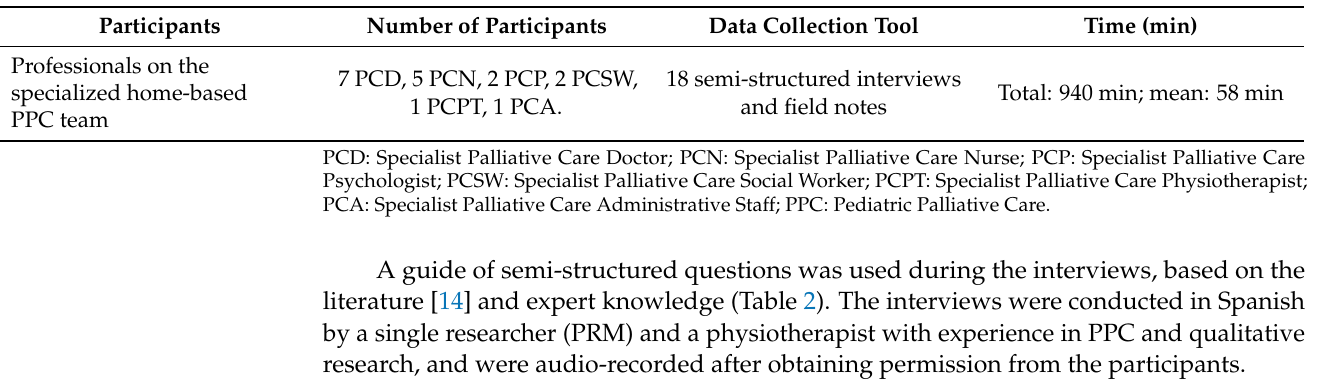
Table 1. Data collection instruments.